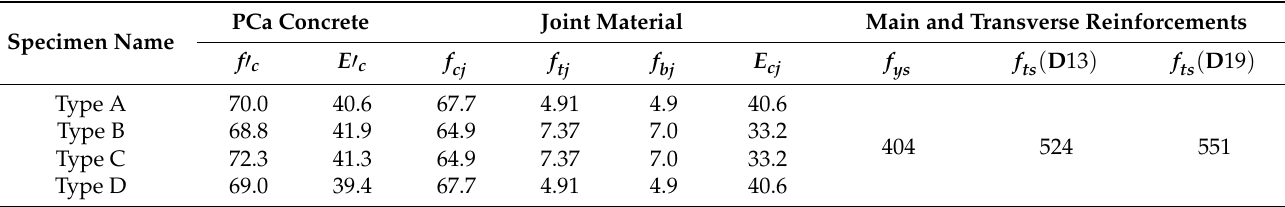
Table 4. Material test results for flexural loading test